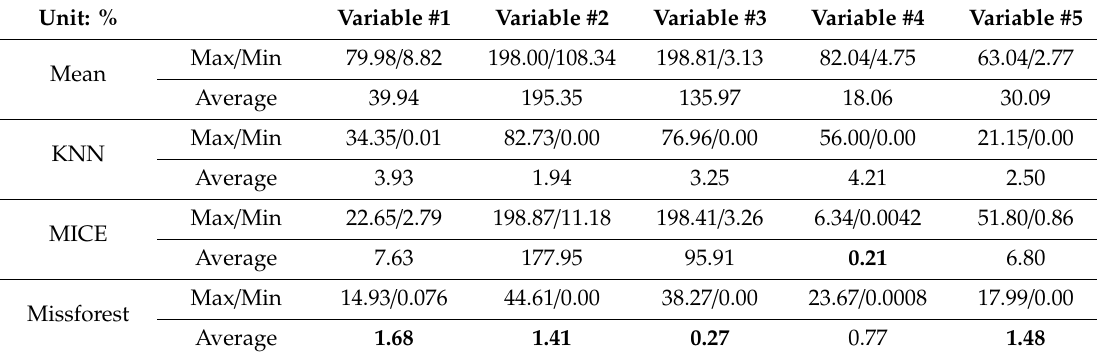
Table 3. Comparative evaluation of imputation accuracy and computation time with symmetric mean absolute percentage error (sMAPE) metric.